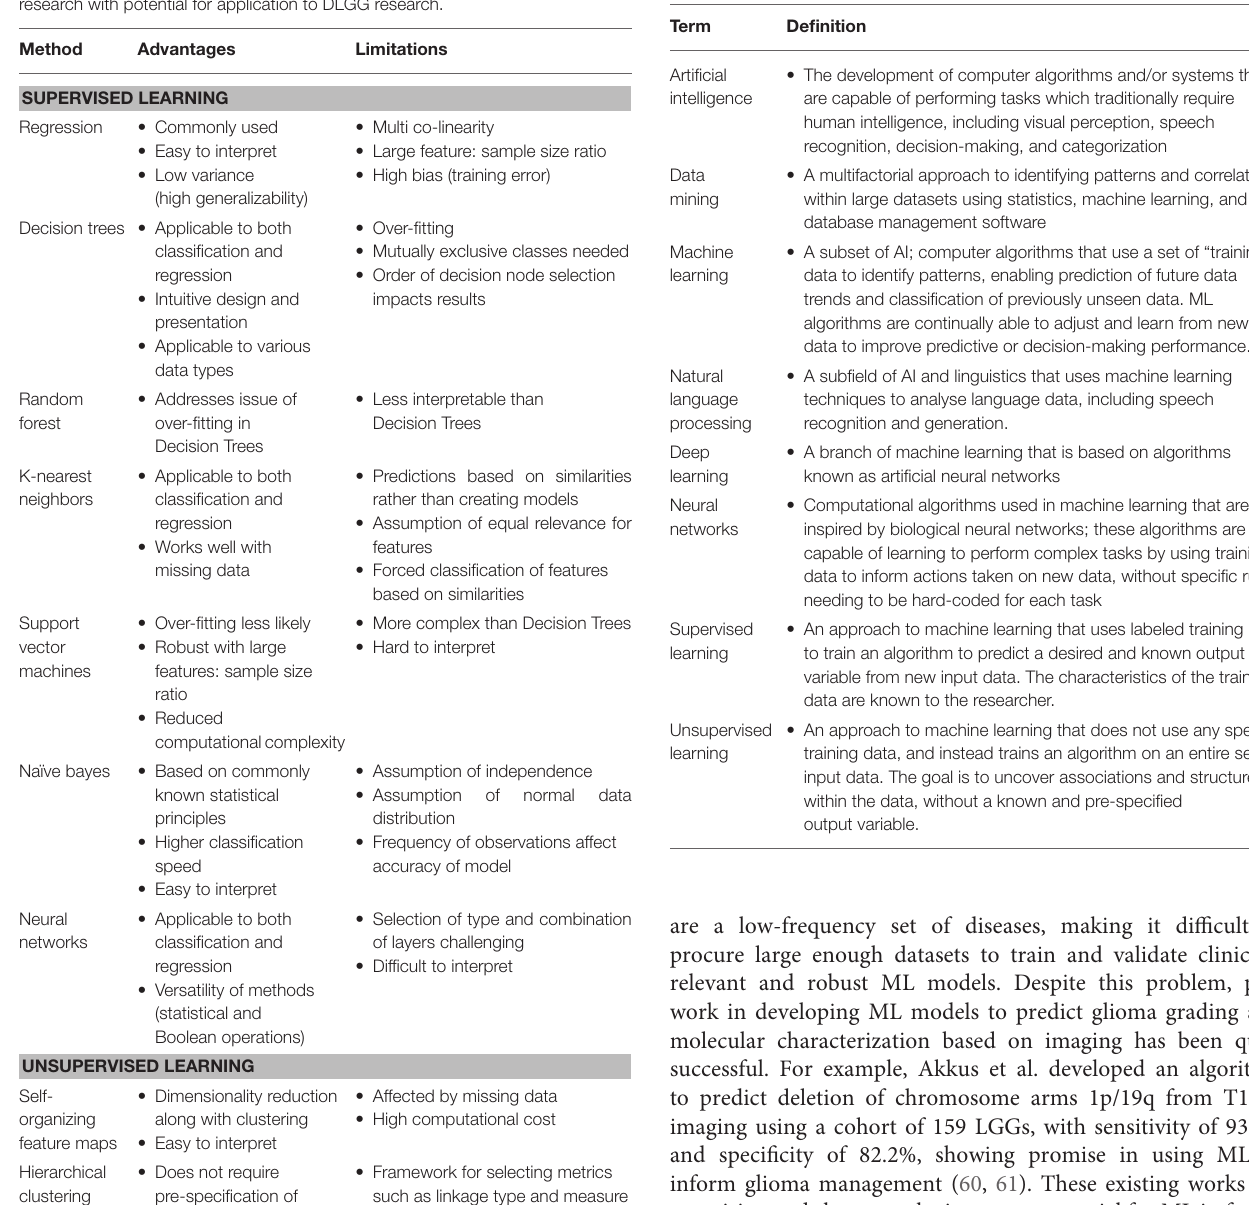
TABLE 2 | Common terms and definitions used in machine learning